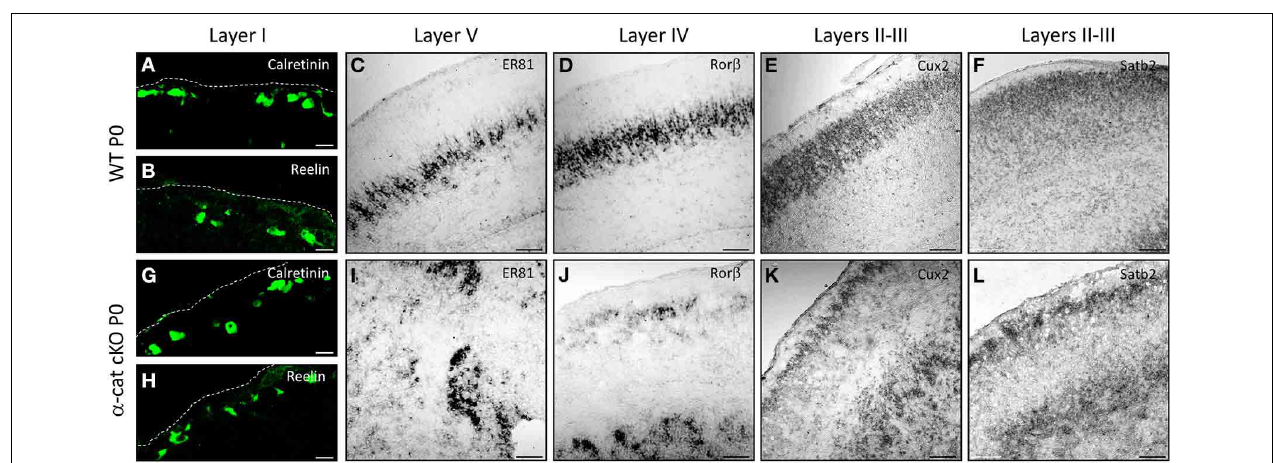
FIGURE 3 | Characterization of the SBH cell identity in the α -cat cKO cortex. Micrographs of coronal sections of P0 WT (A–F) and α -cat cKO (G–L) . Micrographs depict immunostaining (Calretinin, Reelin) or in situ